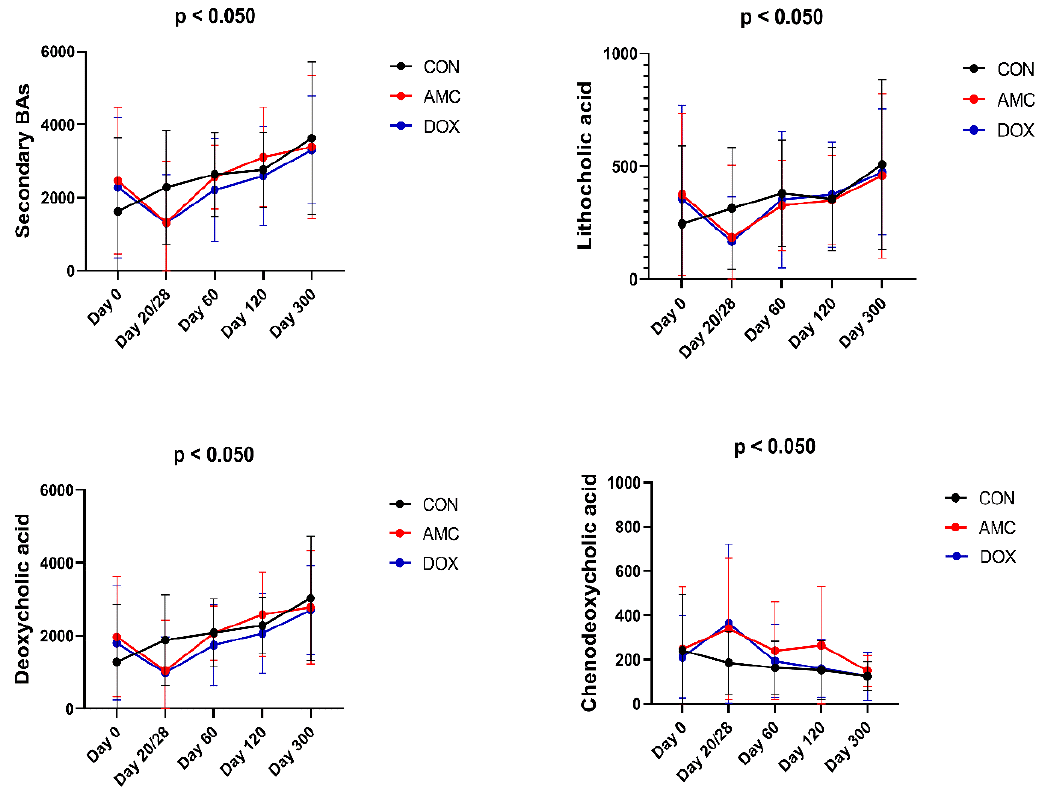
Figure 8. Fecal concentrations of BAs that significantly changed in CON cats over the course of the study. Means and standard deviations are displayed.